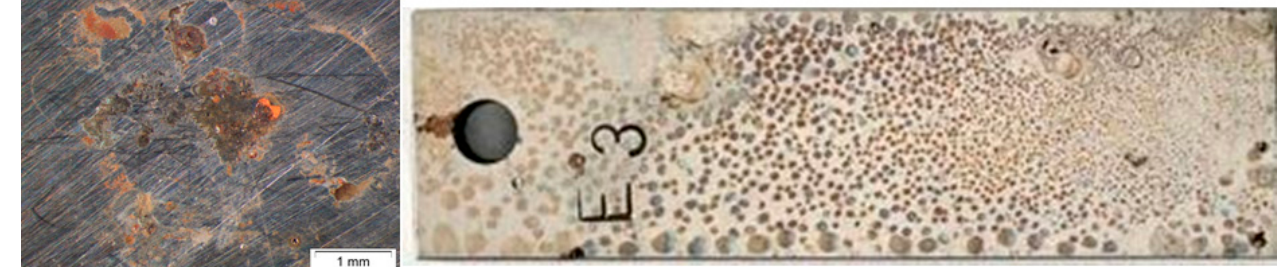
Figure 8. Left: SEM micrographs and element distribution of the ellipsoidal corrosion layer formed on X5CrNiCuNb16-4 hardened and tempered at 670 °C prior to exposure after 8000 h of exposure at 60 °C and 100 bar to water saturated supercritical CO 2 .